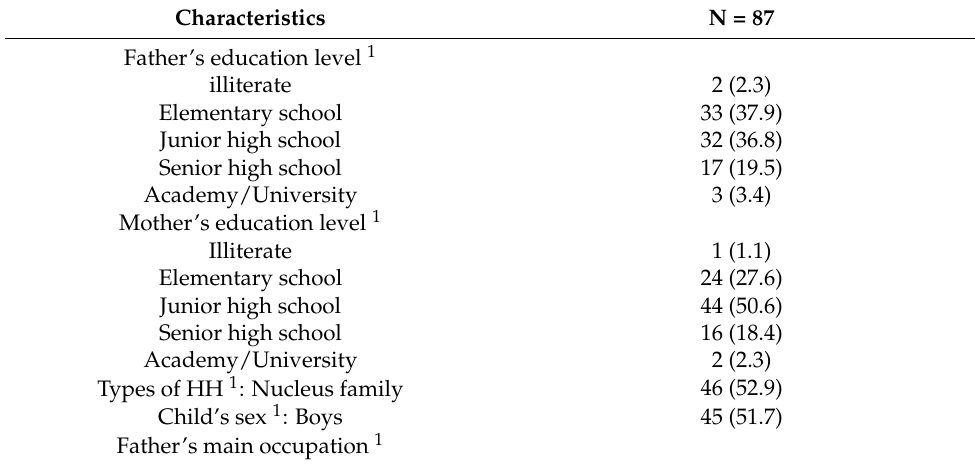
Table 2. General Characteristic of the